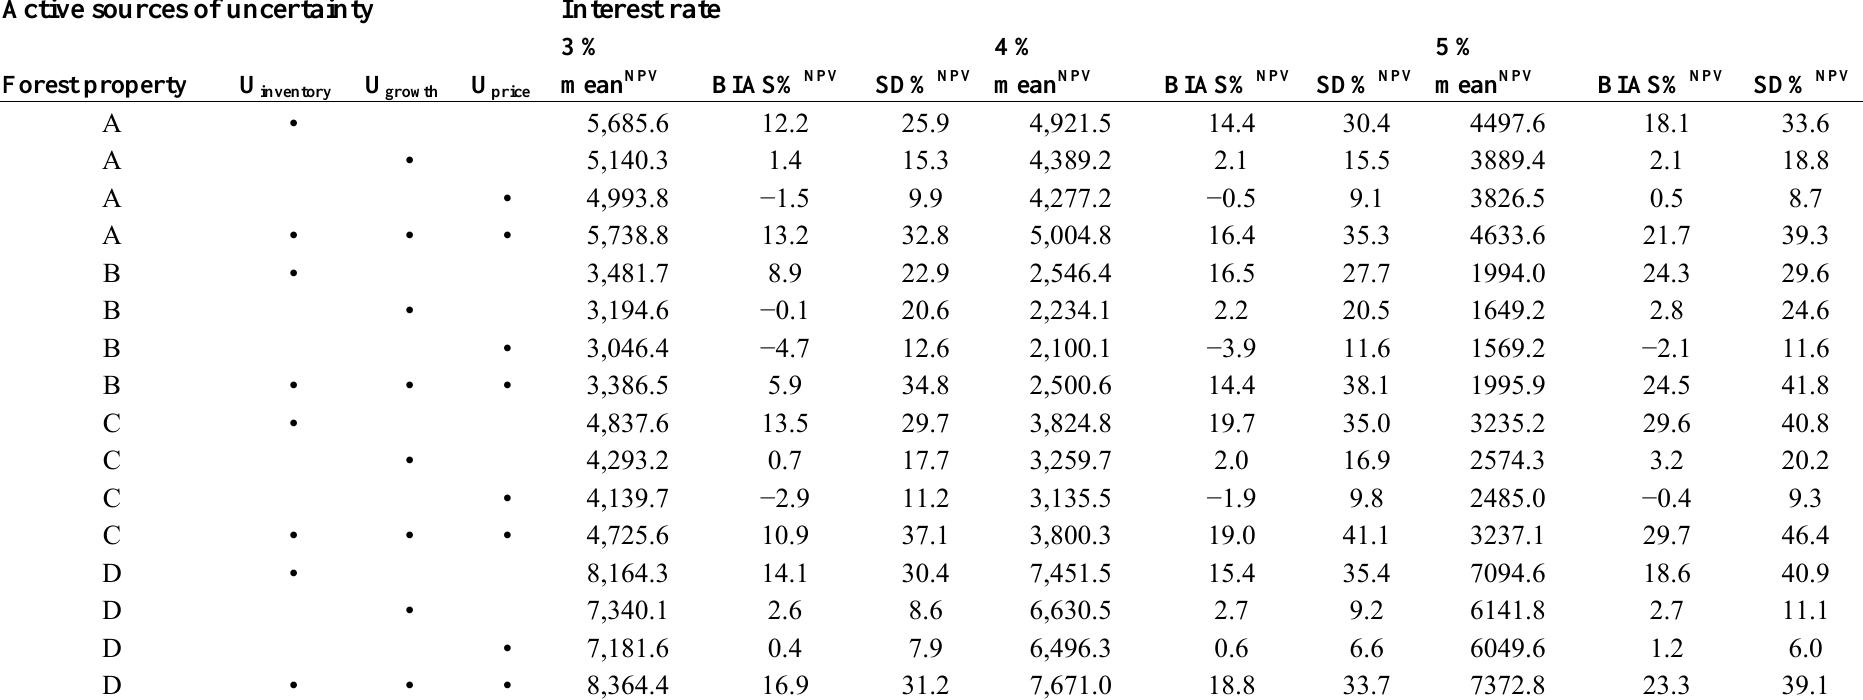
Table 2. Averages of the relative biases (BIAS% NPV ) and standard deviations (SD% NPV ) of the simulated NPV distributions per hectare with given sources of uncertainty and interest rate